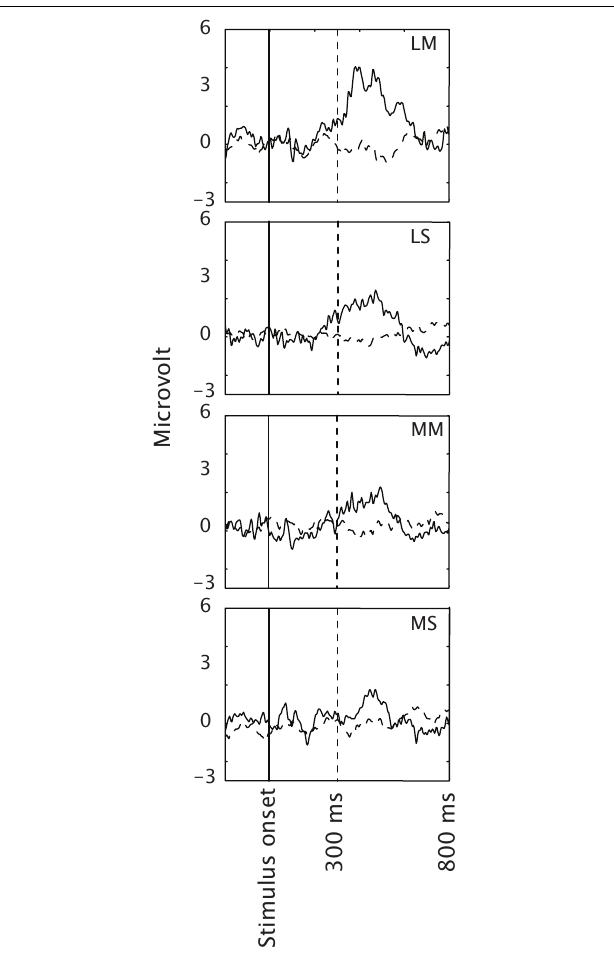
FIGURE 7 | EEG averaged across participants and presented separately for targets (solid lines) and distracters (dashed lines) in the four conditions of Experiment 2b. LL: Long On–Long Off, LS: Long On–Short Off, MM: Medium On–Medium Off, MS: Medium On–Short Off. Only data from electrode Pz is